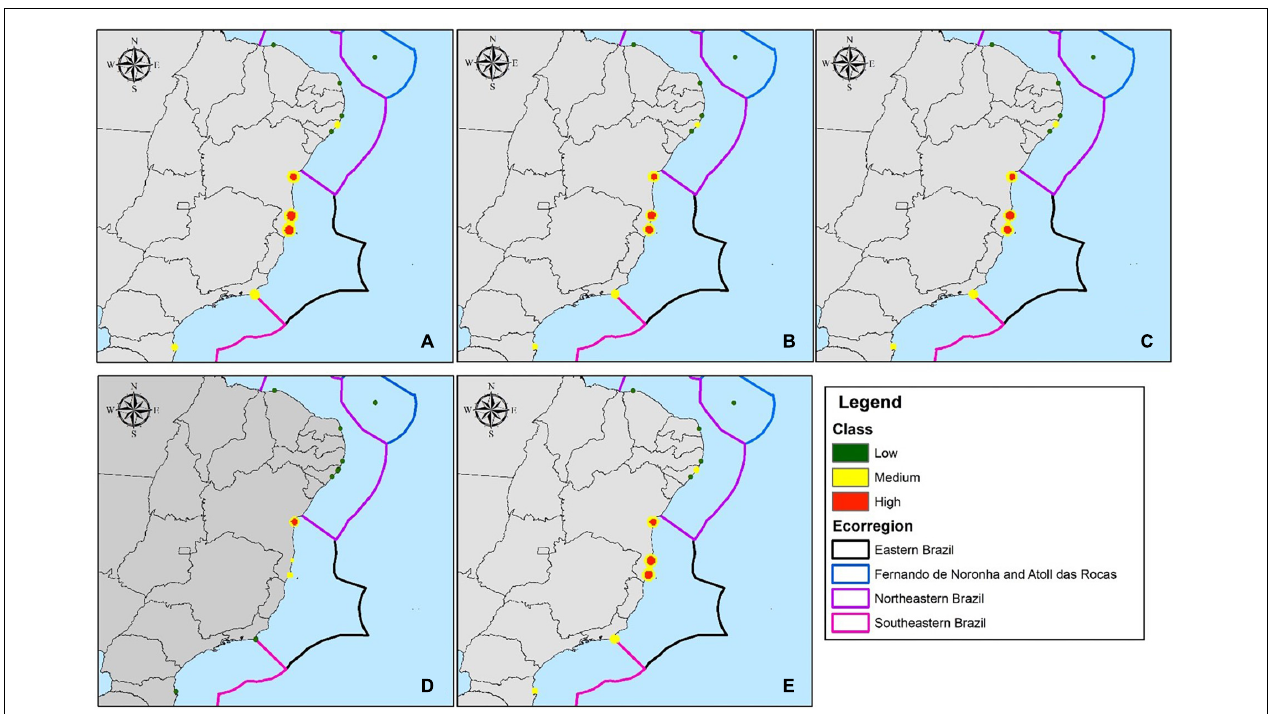
FIGURE 5 | Heat maps indicating the concentration of information obtained on octopus fishing and the ecological factors of Callistoctopus furvus , in each of the four Brazilian marine ecoregions included in this study. The information is presented in five categories: (A) general factors of octopus fishing; (B) seasonality; (C) fishing effort; (D) sale; and (E) factors of C. furvus fishing. The marine ecoregion with the highest concentration of information in the five categories was eastern Brazil, high class, in